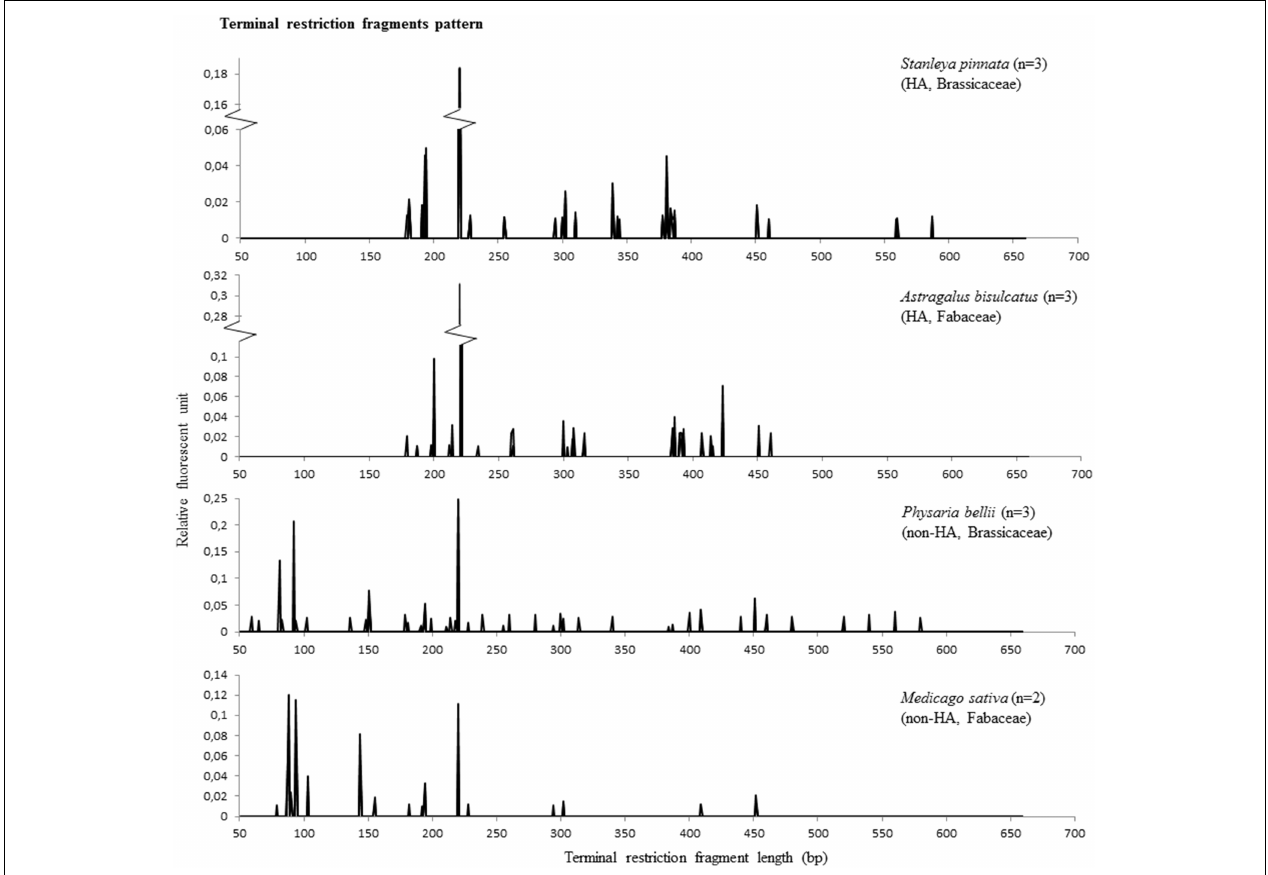
FIGURE 2 | T-RFLP results representing microbial diversity in endophytes of hyperaccumulator species S. pinnata (Brassicaceae) and A. bisulcatus (Fabaceae) as well as non-hyperaccumulators collected from the same seleniferous